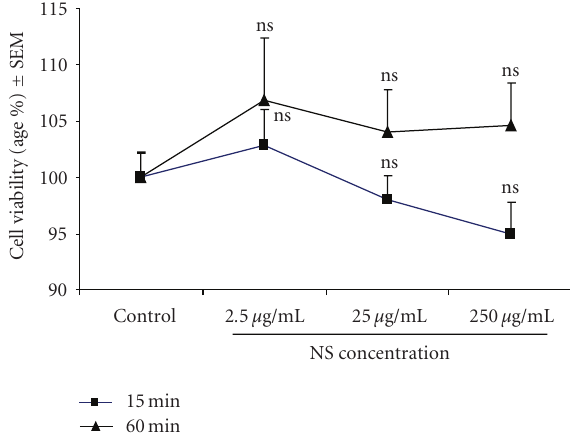
Figure 1: E ff ect of Nigella sativa methanolic extract on neuronal viability measured by MTT assay. The cells were stimulated for 15 and 60 minutes with di ff erent concentrations of this extract (2.5, 25 and 250 μ /mL, final concentration). The results are presented as ± SEM of three independent experiments and statistical analysis resulted in no significant di ff erences when compared with the control